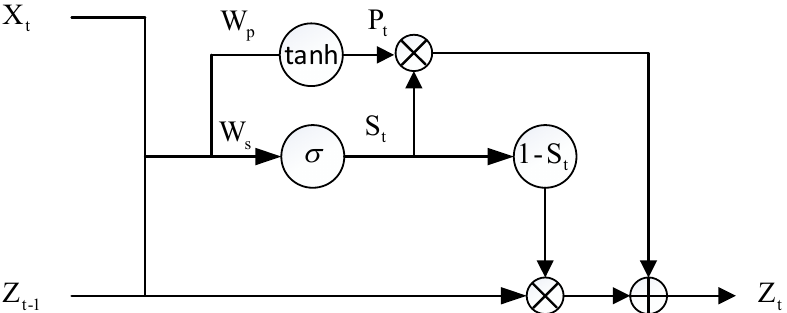
Figure 4. In GHU, the gradient highway connects the current time step directly with previous inputs. σ ( · ) is a Sigmoid function.